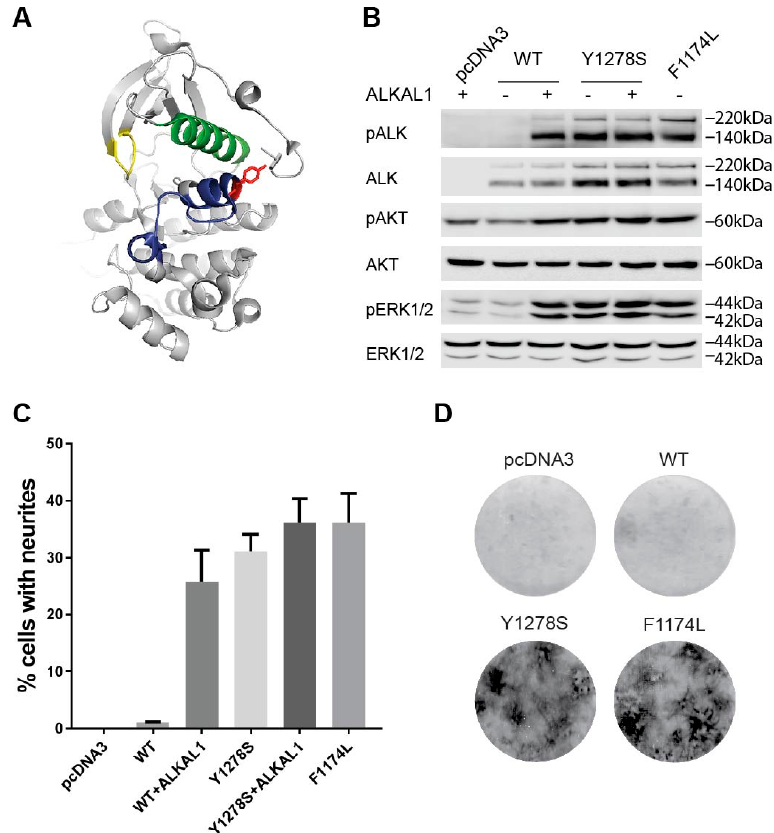
Figure 1. Characterization of ALK-Y1278S. ( A ) Ribbon diagram of the inactive Anaplastic Lymphoma Kinase (ALK) kinase domain indicating the location of Y1278 (red stick) in the activation loop (dark blue). α C helix: green; glycine rich P-loop: yellow. Image was generated with PyMOL